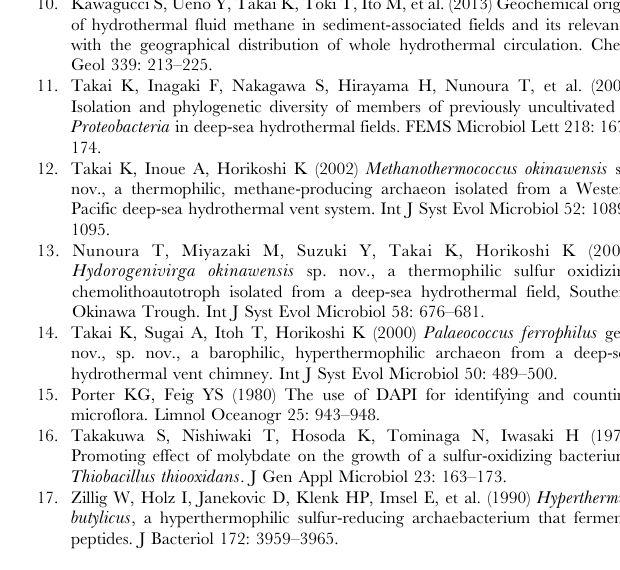
Figure S2 Effects of temperature, pH, NaCl and O 2 on the growth of strain Hiromi 1.